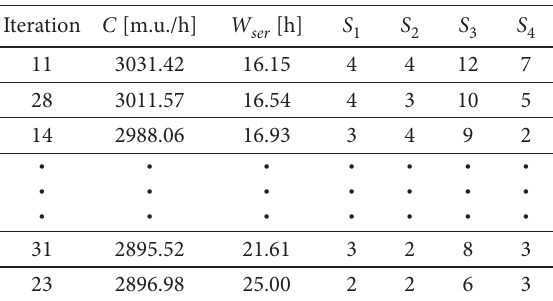
Table 2. Values of objective functions and decision variables for some points on Pareto front Iteration C